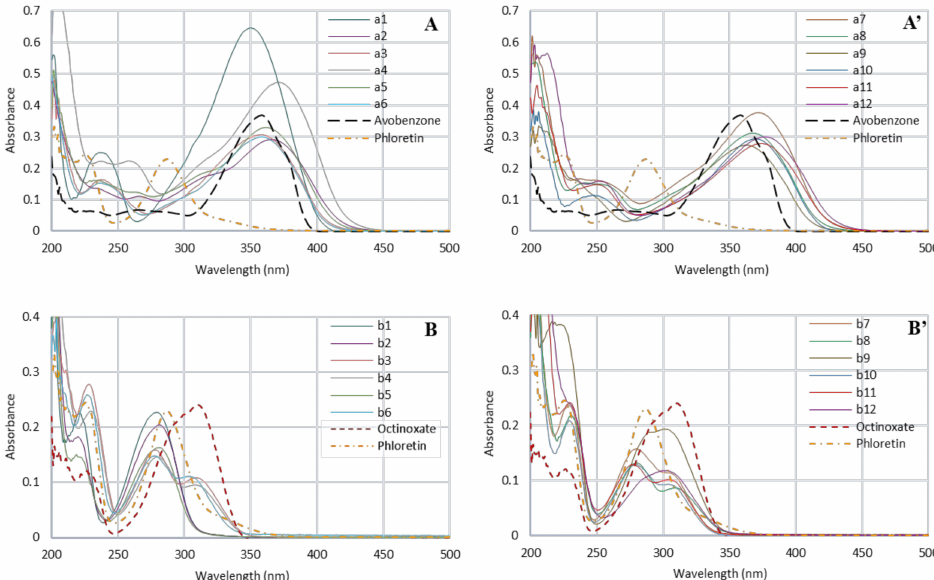
Figure 3. UV-Vis spectrum of chalcones series ( A , A’ ), dihydrochalcones series ( B , B’ ), phloretin (dotted orange line), avobenzone (dotted black line) and octinoxate (dotted red line) at 10 µ M in ethanol. For each series, spectra have been split into two graphics and the scale has been adapted for